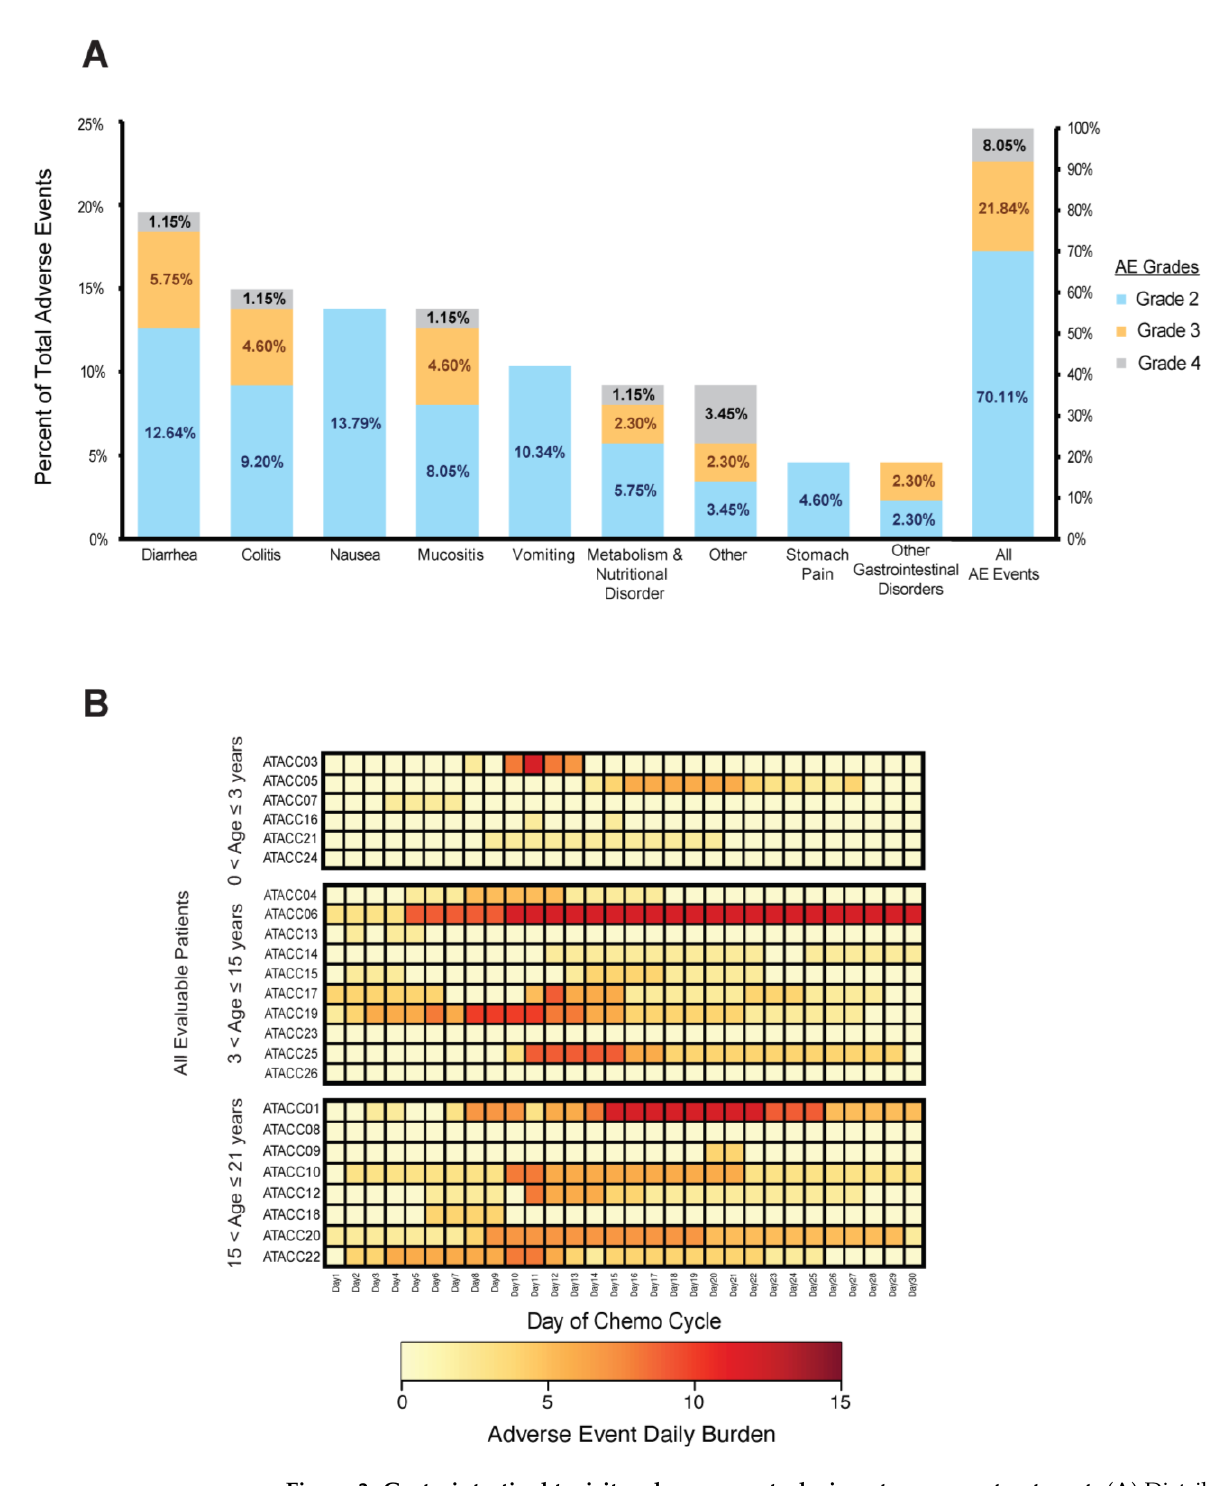
Figure 3. Gastrointestinal toxicity adverse events during atovaquone treatment. ( A ) Distribution of all GI-related adverse events reported on the trial. Each bar represents the percentage that each AE type was observed during the trial; small boxes represent the grades that were recorded for each AE type; percentages in the box represents the chance of an AE at a specific grade occurred during this trial. ( B ) Heatmap of adverse event daily burden (sum of all AE grades assigned each day) for each evaluable patients ( n = 24) throughout the treatment period, patients are group into their respective age ranges.